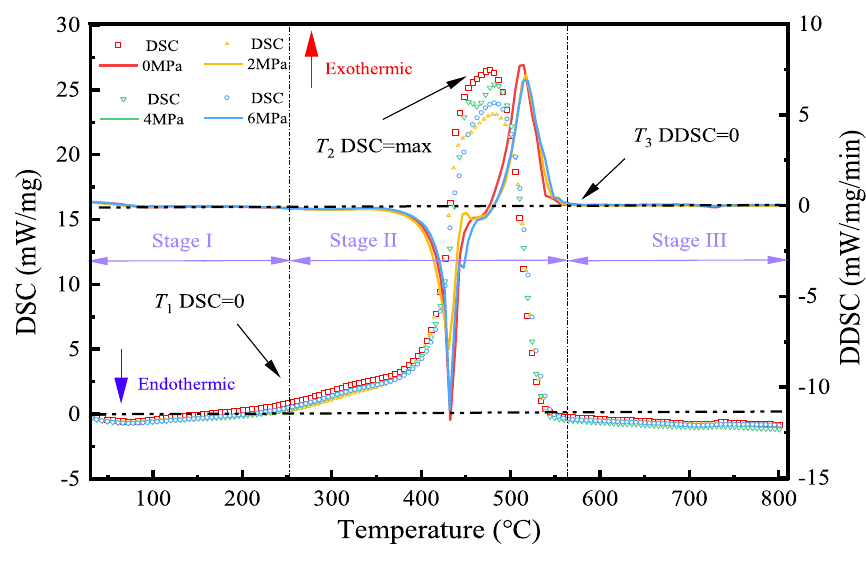
of coal re-ignition under differ- ent uniaxial